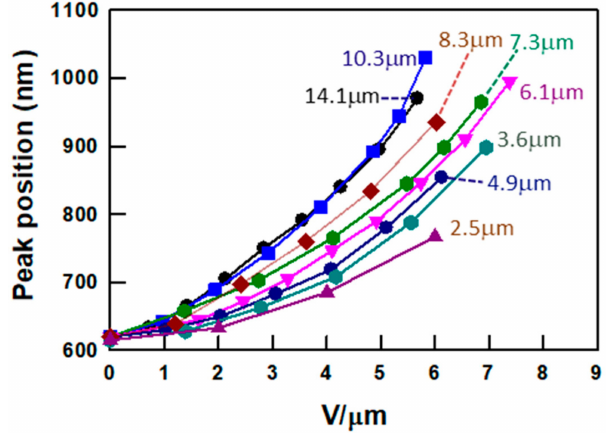
Figure 4. Peak position of the reflection band of PSCLCs with various cell thicknesses as a function of the DC